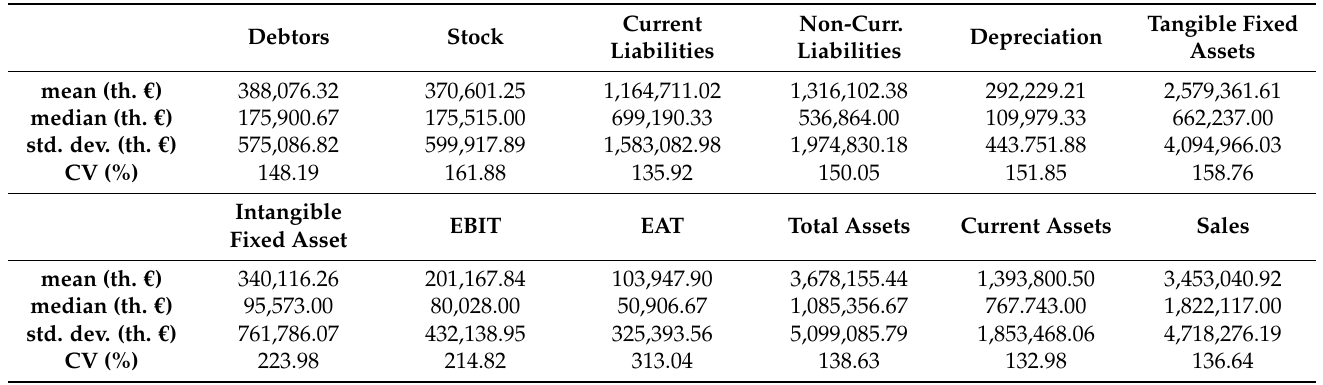
Table 2. Descriptive statistics of fundamental corporate parameters.